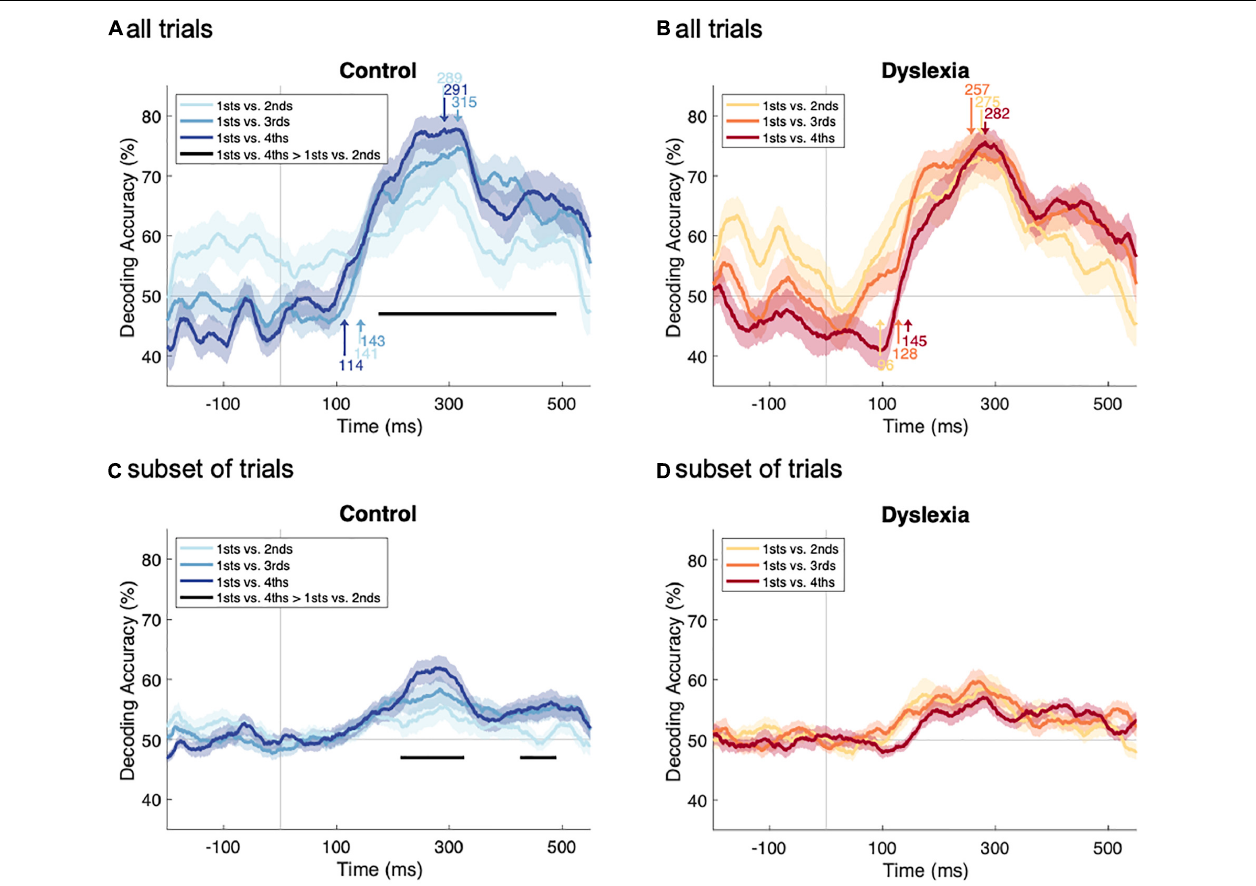
FIGURE 4 | Comparing deviant-vs.-standard decoding as a function of repetition history. (A,B) Decoding-accuracy time series from Figure 3A (all trials), overlaid for easier comparison within Control (A) and Dyslexia (B) groups. Arrows in the lower portion of each panel indicate the onset latencies, in ms, of significant deviant-vs.-standard decoding. Arrows in the upper portion of each panel indicate latencies, in ms, of peak decoding accuracy. In Control, there is a significant difference in accuracy between 1sts-vs.-4ths decoding and 1sts-vs.-2nds decoding. (C,D) Decoding-accuracy time series from Figure 3B (subset of trials), overlaid for easier comparison within Control (C) and Dyslexia (D) groups. With reduced trial numbers, there is again, in Control, a significant difference in accuracy between 1sts-vs.-4ths decoding and 1sts-vs.-2nds